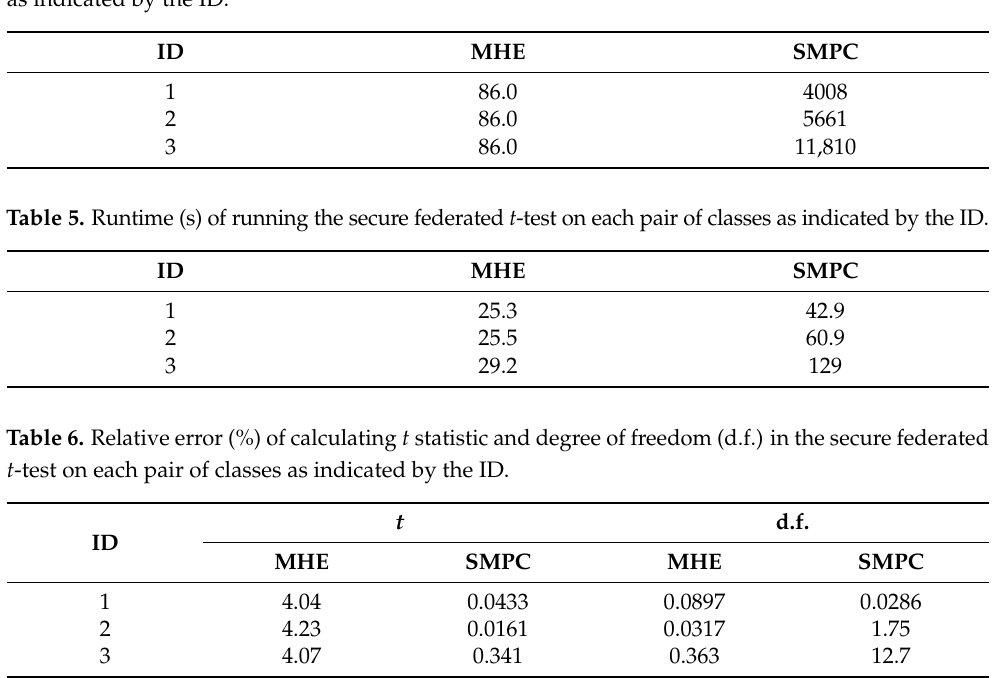
Table 4. Communication overhead (MB) of running the secure federated t -test on each pair of classes as indicated by the ID.